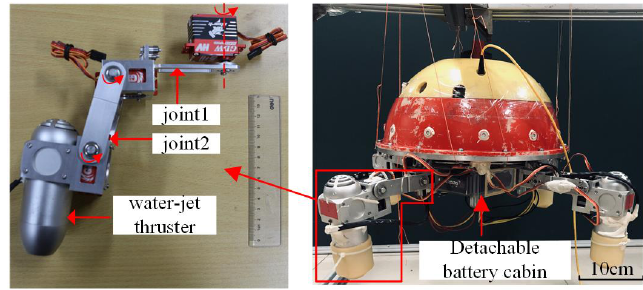
Figure 2. Detailed structure of the vector propulsion